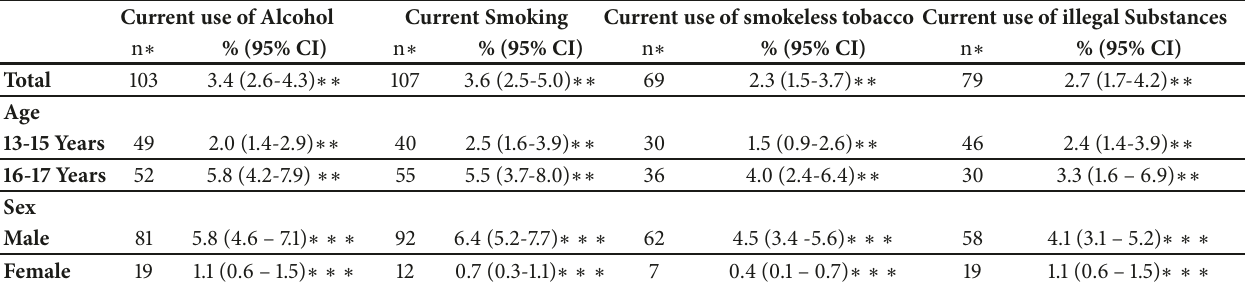
Table 2: Prevalence of current use of alcohol consumption, smoking, smokeless tobacco, and illegal substances among the study participants (N = 3173).